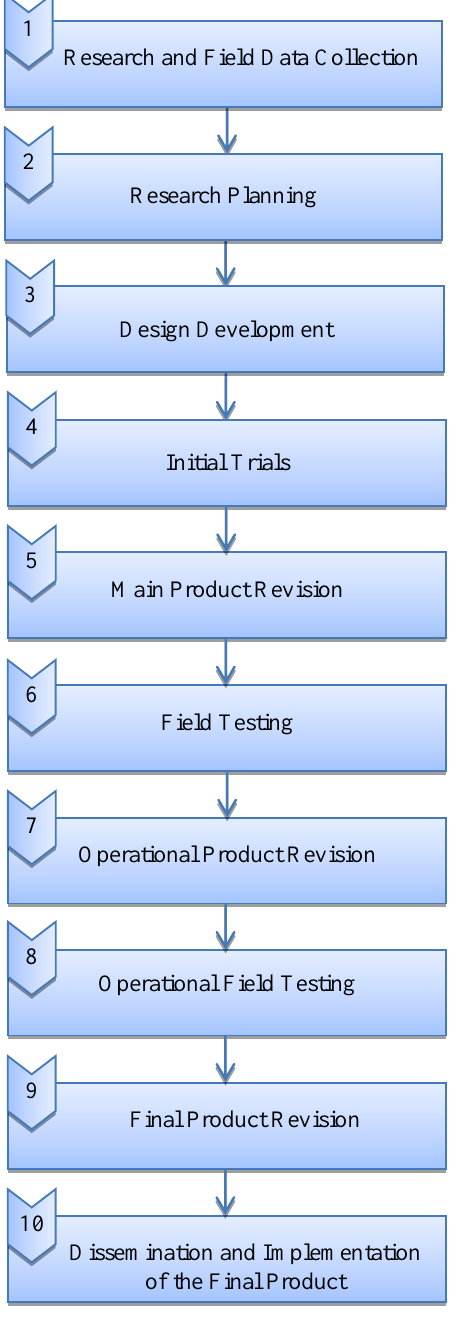
Figure 2. The Research Stages that Refer to the Borg and Gall